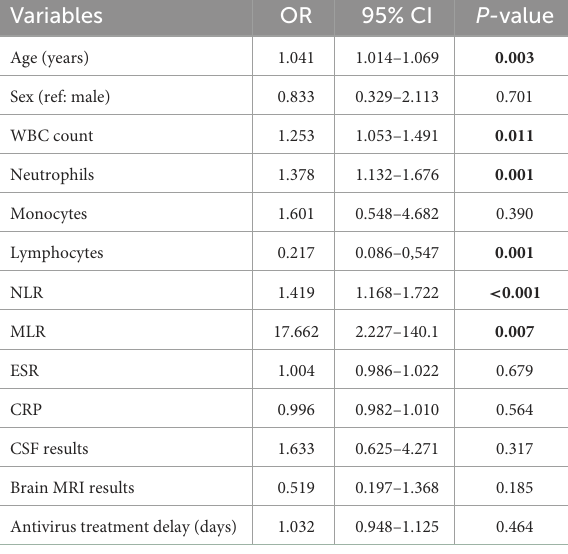
TABLE 2 Univariate analysis for clinical outcome in patients with VE. Variables